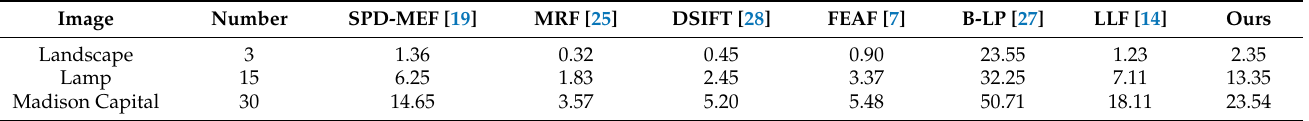
Table 5. Time (s) comparison of the proposed method with six existing